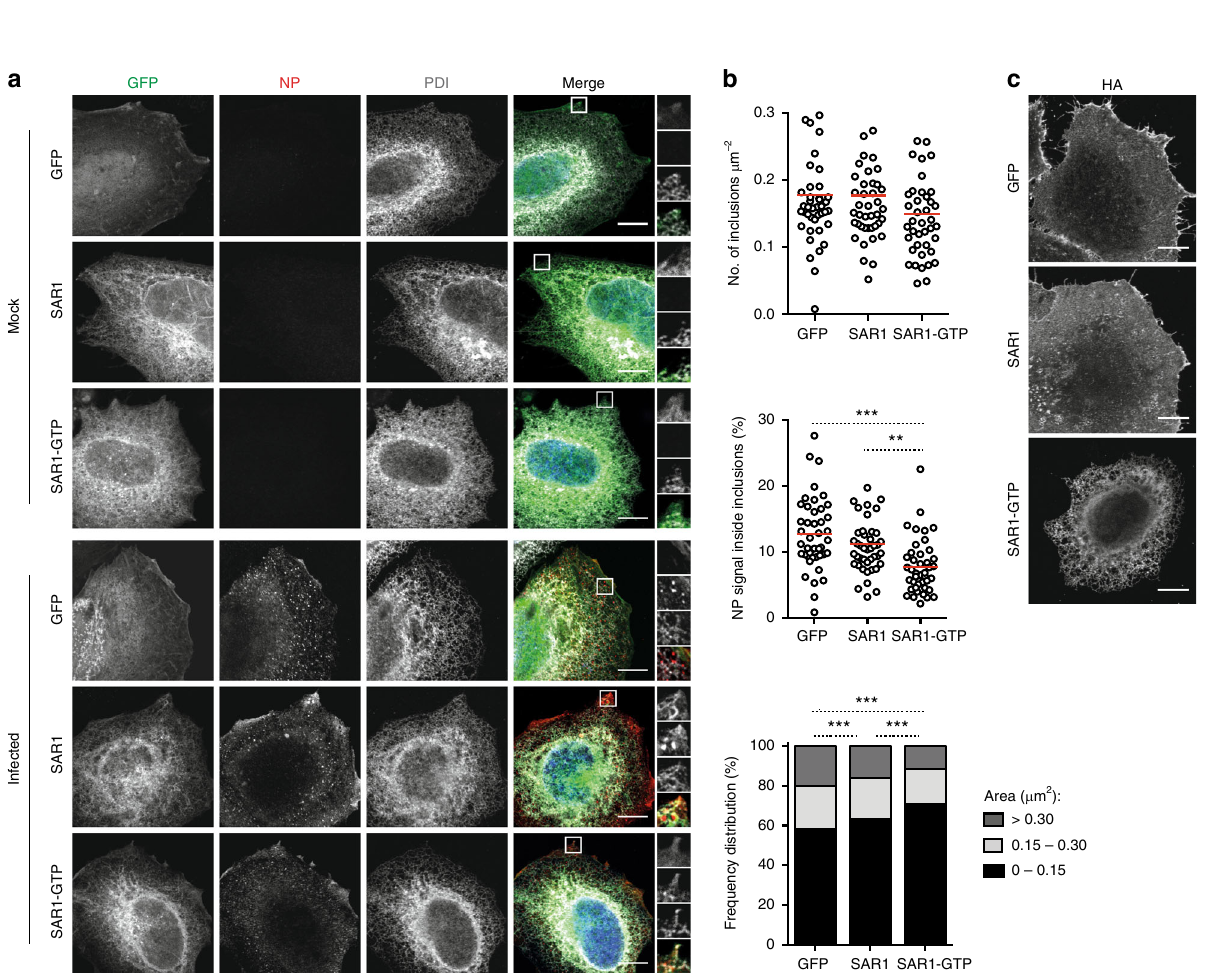
Fig. 7 Disruption of ER exit sites dissolves viral inclusions. HeLa cells were transfected with plasmids encoding GFP, SAR1 WT-GFP (SAR1) or SAR1-GTP- GFP (SAR1-GTP) and, 24 h later, infected or mock-infected with PR8 virus, at an MOI of 10. At 16 hpi, cells were fi xed and processed for immuno fl uorescence. a Cells were stained for the viral protein NP (in red) and for the ER protein PDI (in gray). Areas highlighted by the white box are shown on the right of each panel. b The number of inclusions per μ m 2 , the percentage of NP staining that is inside inclusions and the frequency distribution of NP inclusions within the three area categories (in μ m 2 ) were plotted for each condition. Statistical analysis of data was performed using a non- parametric Kruskal – Wallis test, followed by Dunn ’ s multiple comparisons test (*** p < 0.001). More than 40 cells from 2 independent experiments were analyzed per condition. c Infected cells were stained for the viral protein HA and imaged by confocal microscopy. Bar = 10 μ